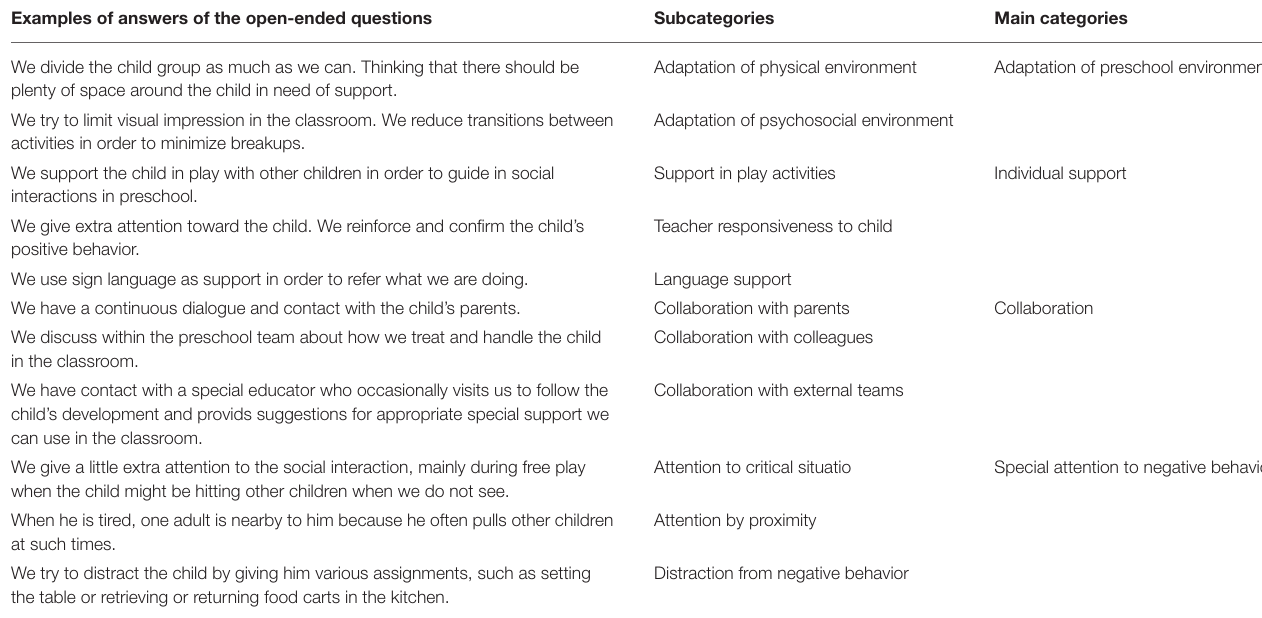
TABLE 7 | Content analysis of open-ended questions of the SDQ impact